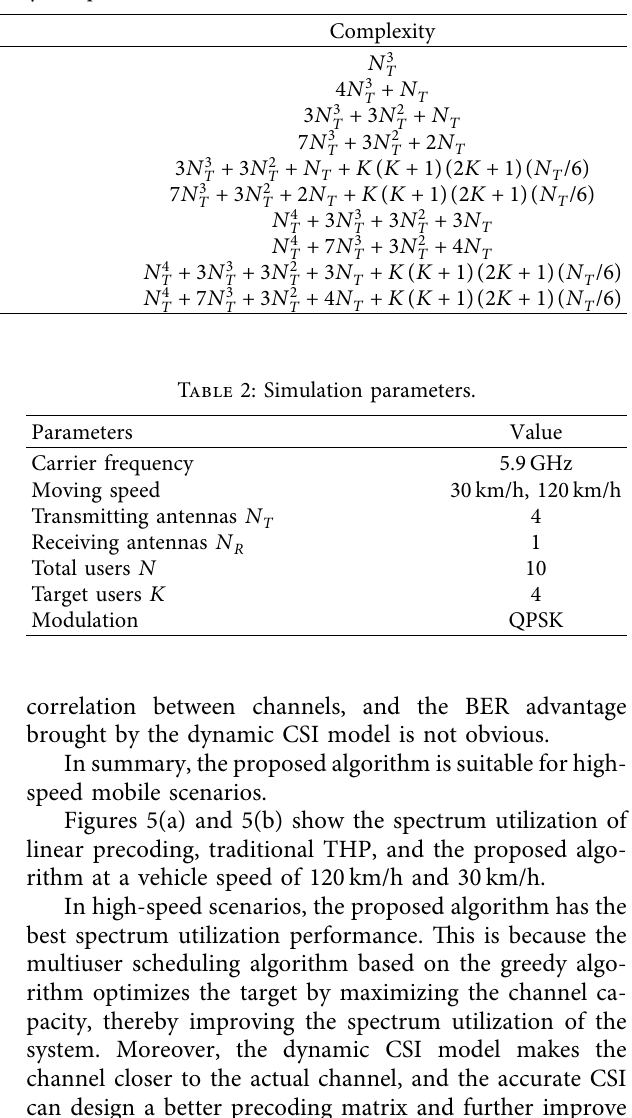
Table 1: Complexity comparison.